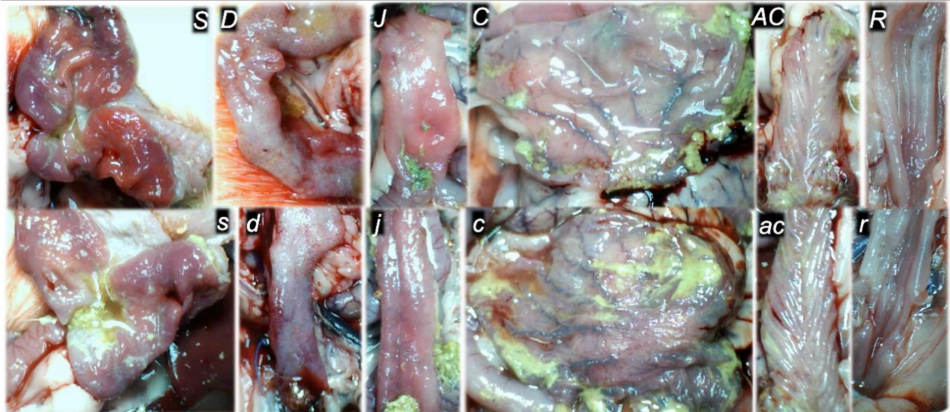
Figure 10. At 30 min ligation-time, gross presentation of the mucosa of the stomach ( s , S ), duodenum ( d , D ), jejunum ( j , J ), cecum ( c , C ), ascending colon ( ac , AC ), and rectum ( r , R ), in the rats with the occluded superior mesenteric vein and artery, in the rats that received saline medication (5 mL/kg ip) (control, low, small letters) or BPC 157 medication (10 ng/kg ip) (upper, capitals). Camera attached to a VMS-004 Discovery Deluxe USB microscope (Veho, Dayton, OH,